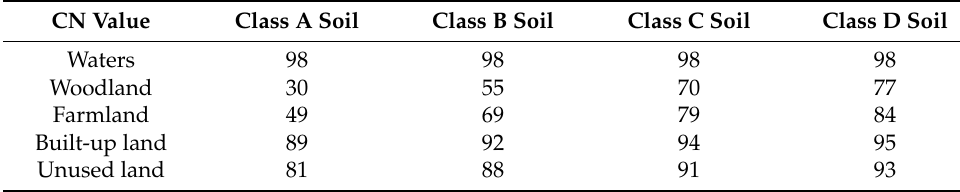
Table 1. Curve numbers for different hydrologic soil